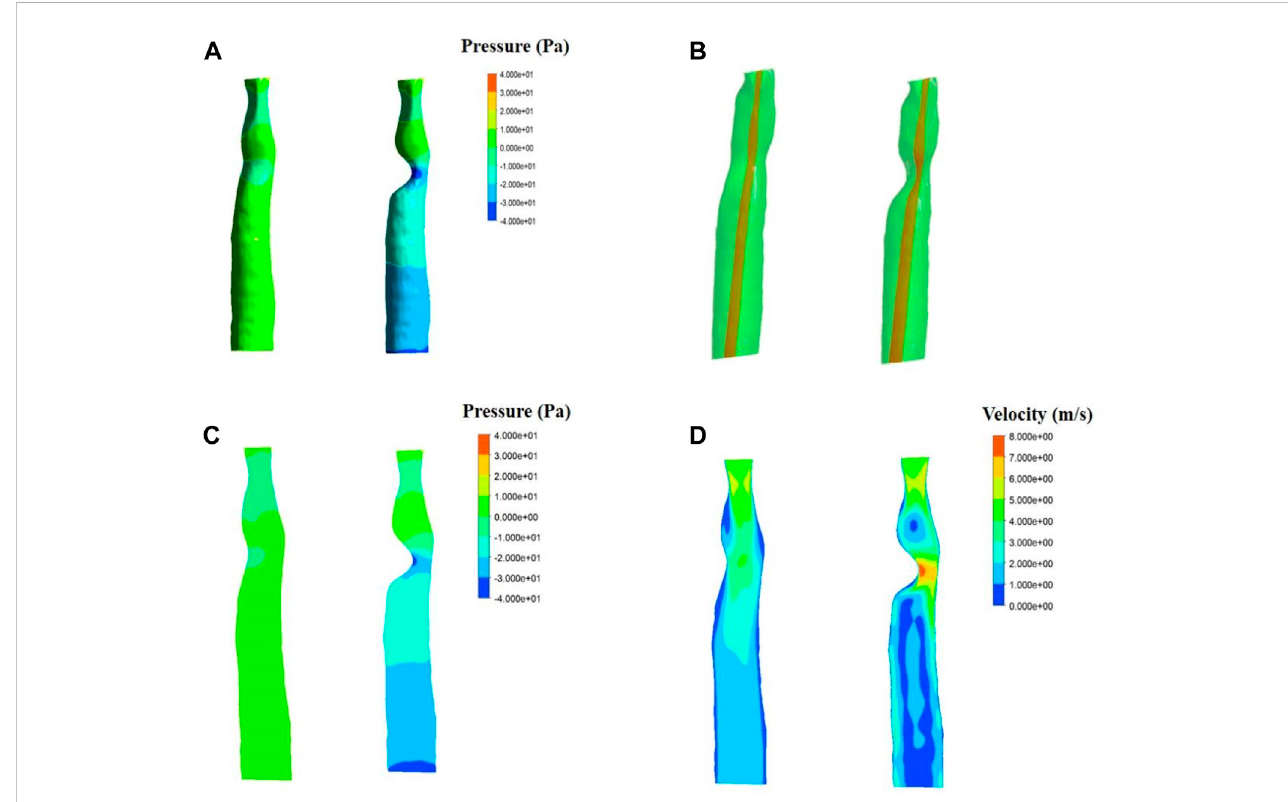
FIGURE 6 Fluidsimulationsassociatedwithpatienttwo.Simulationsforanormaltracheaareontheleftsideofeachpanel,whilesimulationsincluding50%stenosis are on the right. (A) . Results of fl uid pressure. (B) . Section position (shown in red). (C) . Contours of velocity distribution. (D) . Contours of pressure distribution.